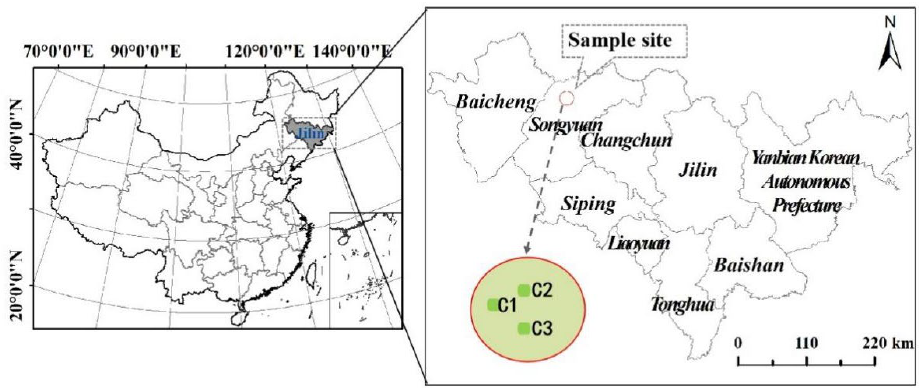
Figure 1. The location of sample site in Songyuan city, northeast of China. C1, C2, and C3 refers to the cornfields sample plots with different soda-alkali status in the study. Table 1. Soil physical-chemical properties.